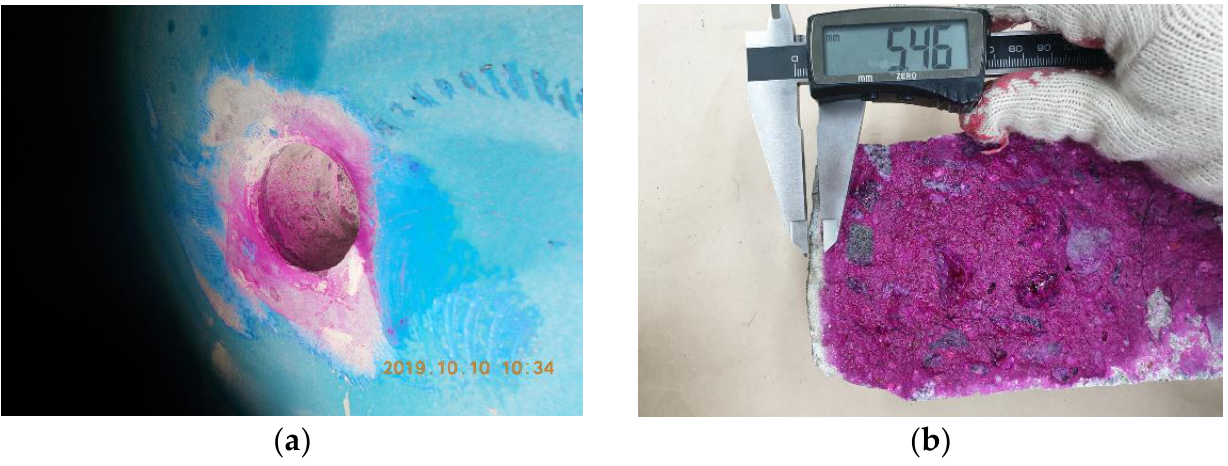
Figure 2. Carbonation depth measurement. ( a ) Measurement of carbonation depth in the core sampling area. ( b ) Measurement of carbonation depth of the collected sample core.